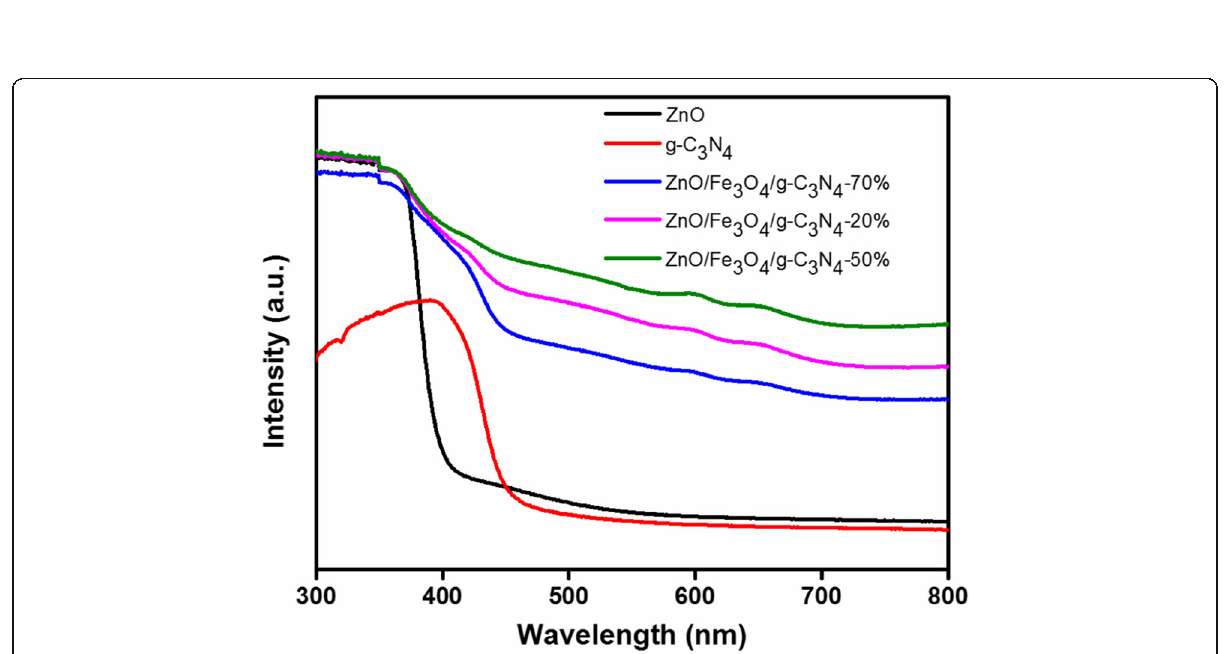
Fig. 5 UV-vis diffuse reflectance spectra of ZnO, g-C 3 N 4 , ZnO/Fe 3 O 4 /g-C 3 N 4 -20%, ZnO/Fe 3 O 4 /g-C 3 N 4 -50%, and ZnO/Fe 3 O 4 /g-C 3 N 4